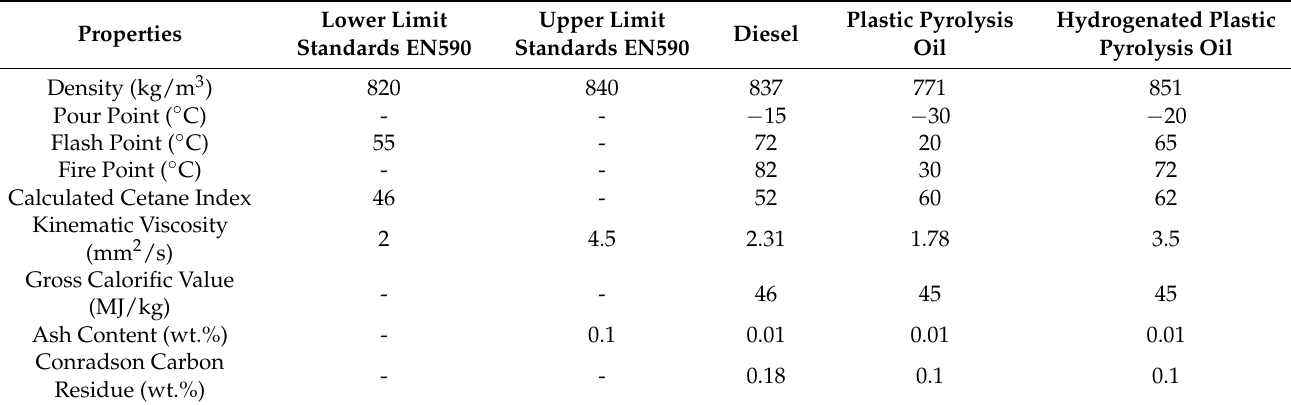
Table 8. Physicochemical properties of diesel, plastic oil and hydrogenated plastic oil